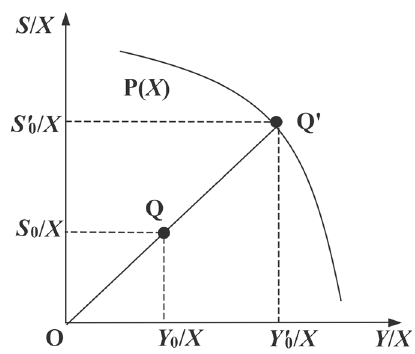
Figure 4. Graphical illustration of NCSPC.